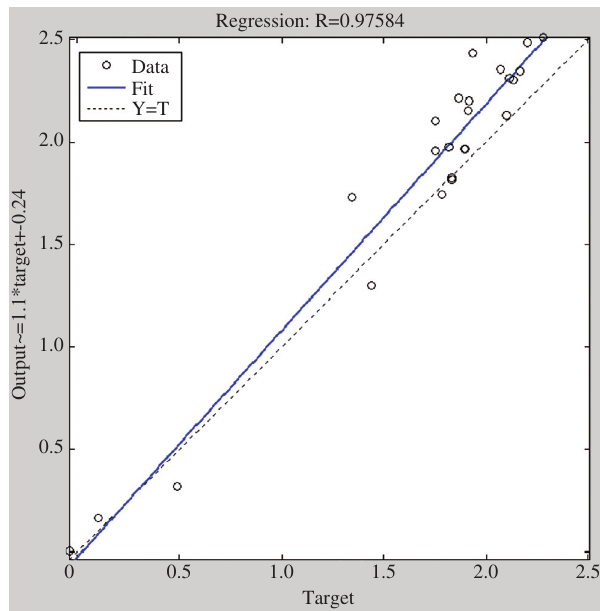
Figure 12. Regression Performance of the BP Neural